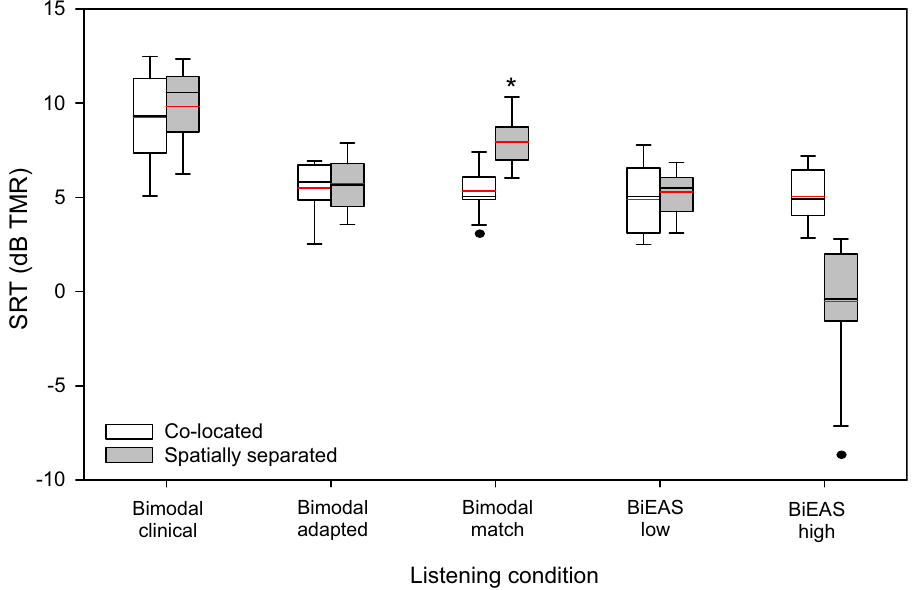
Figure 1. Boxplots of speech reception thresholds (SRTs) with co-located or spatially separated maskers for the five listening conditions. The boxes show the 25th and 75th percentiles, the error bars show the 10th and 90th percentiles, the circles show outliers, the black line shows the median, and the red line shows the mean.